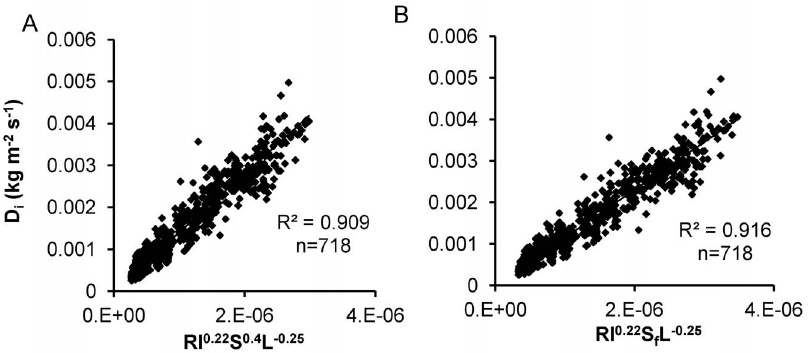
Figure 6. Linear regressions with zero intercept. Linear regression with zero intercept between the interrill erosion rate and the scaling factors R I 0.22 S 0.4 L 2 0.25 (A) and R I 0.22 S f L 2 0.25 (B) to assess the slope factor of S 0.4 and S f .